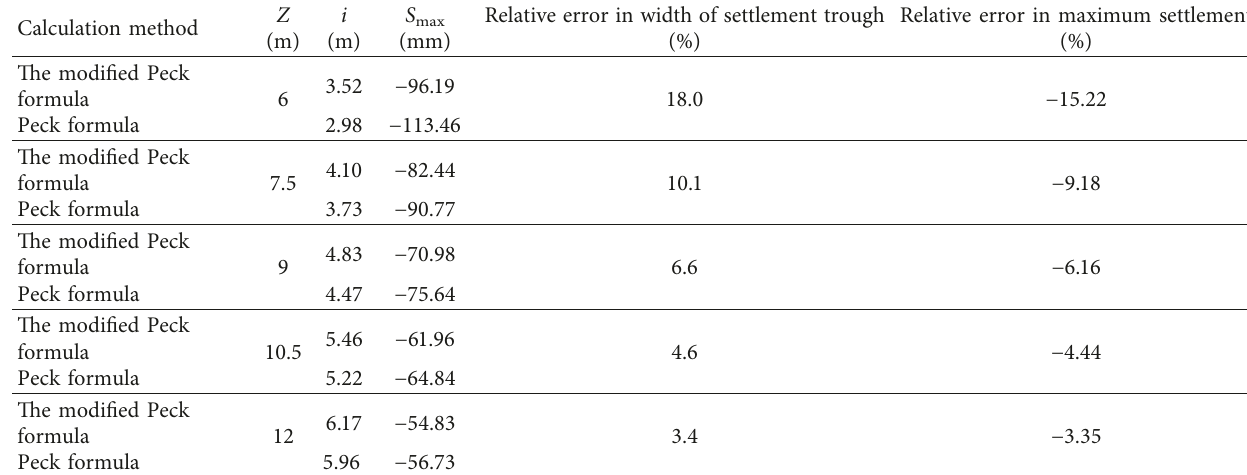
Table 3: The relevant parameters of the settlement curve of each tunnel depth Z